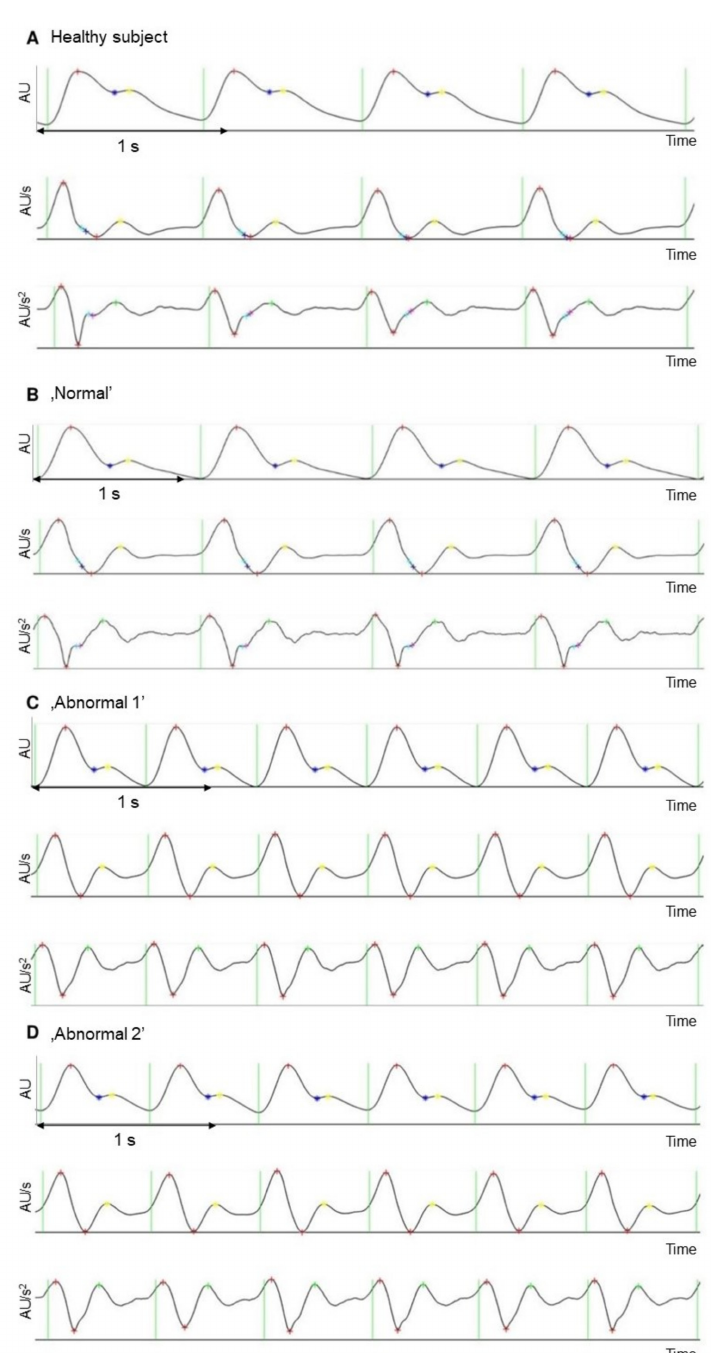
Figure 3. Representative recordings obtained on a healthy individual and the pulse oximeter stimulator. (Panel A ) shows representative recording of one of our healthy subjects. (Panel B ) shows recording of an artificial pulse wave generated by the Normal setting of the pulse oximeter simulator. Recordings of (panels C and D ) demonstrate pulse waves generated by the Abnormal 1 and Abnormal 2 signal settings of the pulse oximeter simulator device. Both are high heart rate signals (95 / min) and are characterized by disappearance of c and d inflections of the second derivative curve. Abnormal 2 setting was a low-intensity signal but was still recorded accurately with the SCN4ALL system. In each panel, the upper graph shows the recorded digital volume pulse (DVP), whereas the middle and lower panels show the first and second derivatives of the DVP, respectively. AU: arbitrary